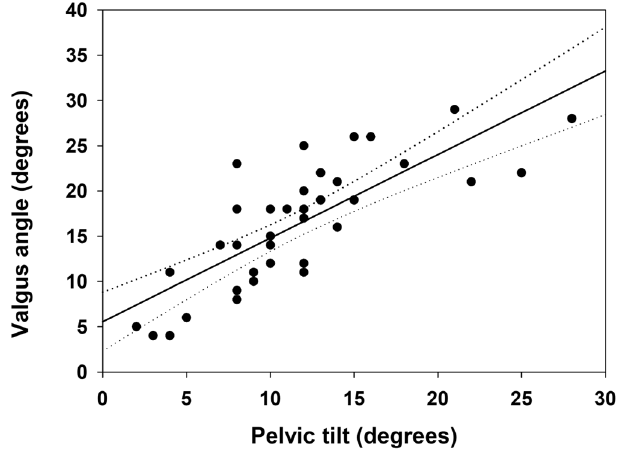
Figure 3. Correlation between valgus angle and pelvic tilt, in the frontal plane, during the Single Leg Squat Test ( n = 38, r = 0.78, 95% CI 0.62 to 0.88).